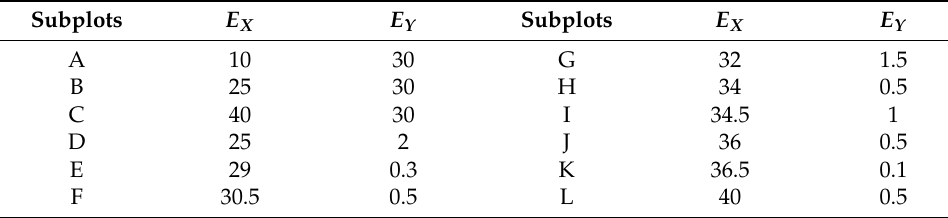
Figure 8. ( a ) Transition sets on the E X − E Y plane. ( b ) The partial enlargement of subplot ( a ); B,H,DL denote bifurcation sets, hysteresis sets, and double limit point sets, respectively. Table 2. Values of E X and E Y corresponding to subplots A through L of Figure